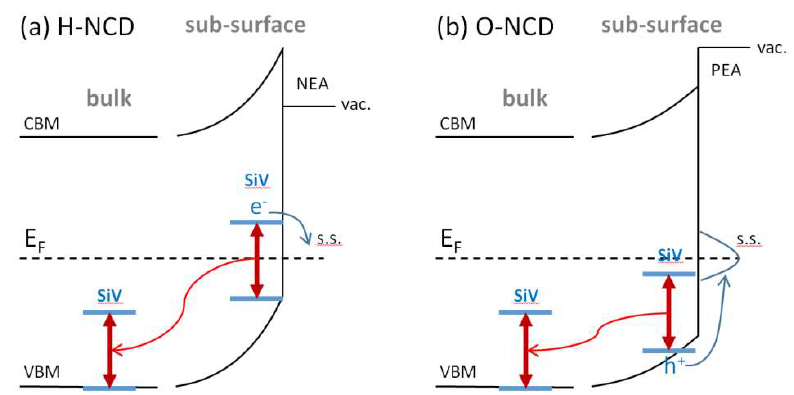
Figure 4. Schematic model of the proposed mechanism for the opposite SPV and its decrease with increasing NCD layer thickness together with increasing PL intensity for the hydrogenated ( a ) and oxidized ( b ) NCD surfaces.